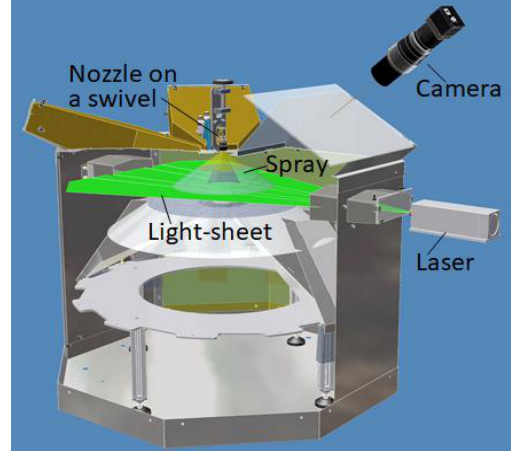
Fig. 1. Scheme of the experiment and optical setup